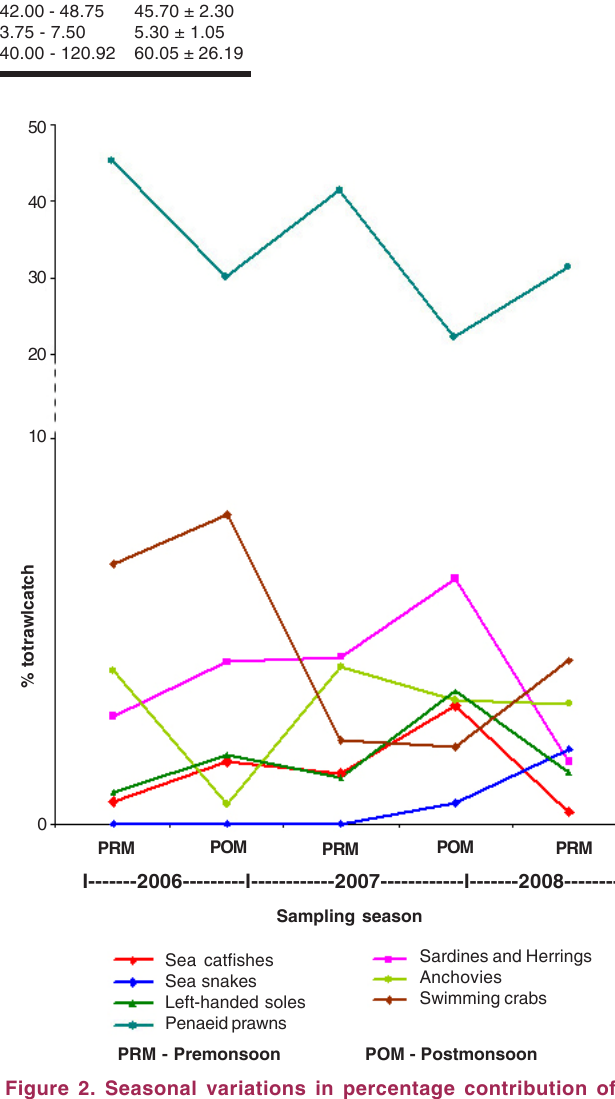
Figure 2. Seasonal variations in percentage contribution of sea snakes and their prey items to total trawl